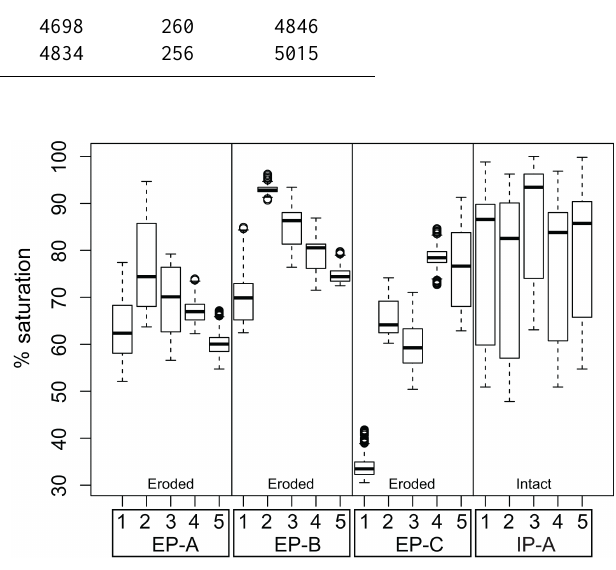
Figure 5. Variability of moisture conditions during the summer of 2013 (percent saturation) per polygon, for each sensor. The line located in the center of each box indicates the median, lower box line indicates the first quartile and the higher line indicates the third quartile; points are outliers. Underlying data refer to the variability of Fig.